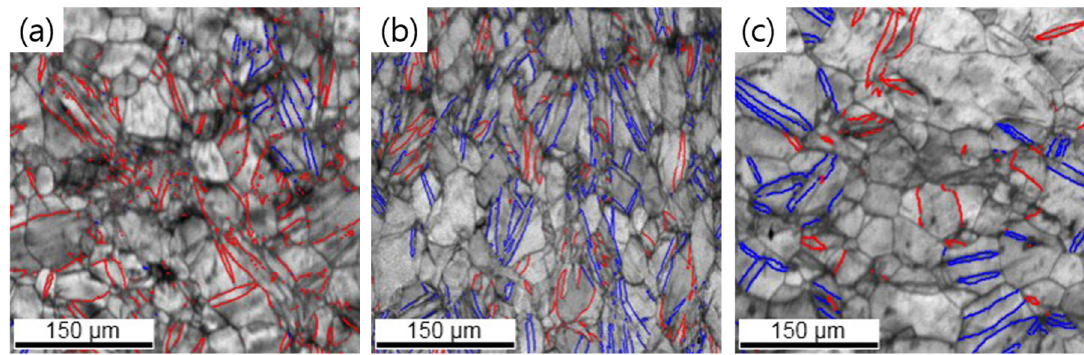
Figure 5. EBSD image quality map with marked twin boundaries at a compressive strain of 0.2 along ( a ) RD, ( b ) ND, and ( c ) TD. Red and blue lines indicate {10 − 12} and {11 − 22} twin boundaries, respectively.